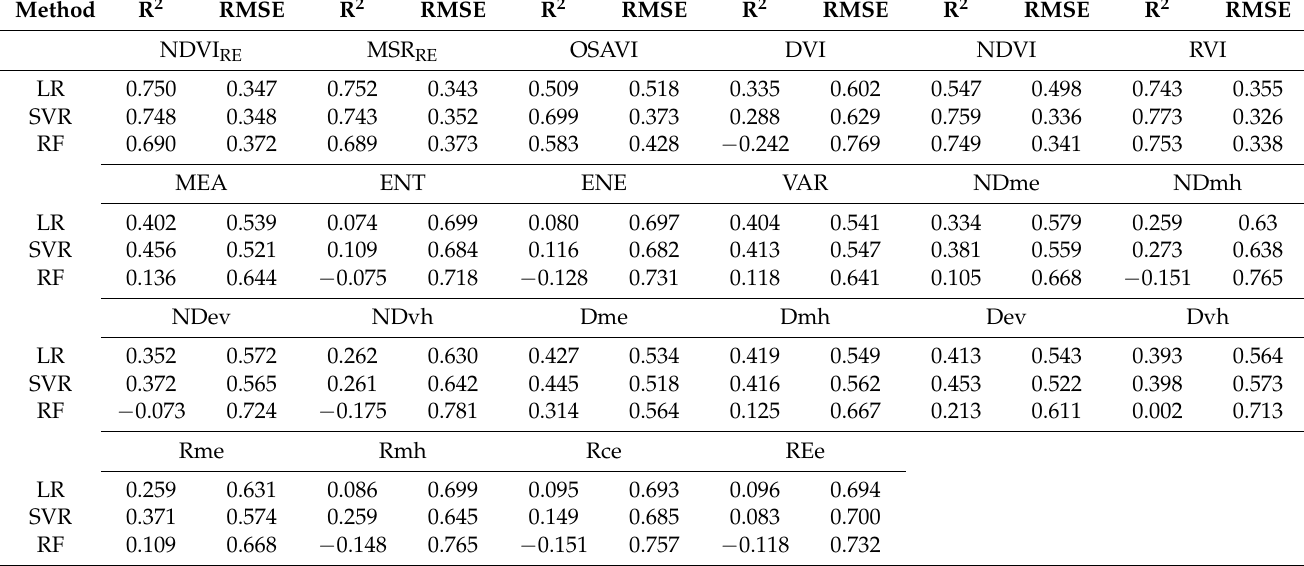
Table 6. LAI estimation results based on single remote sensing factors.